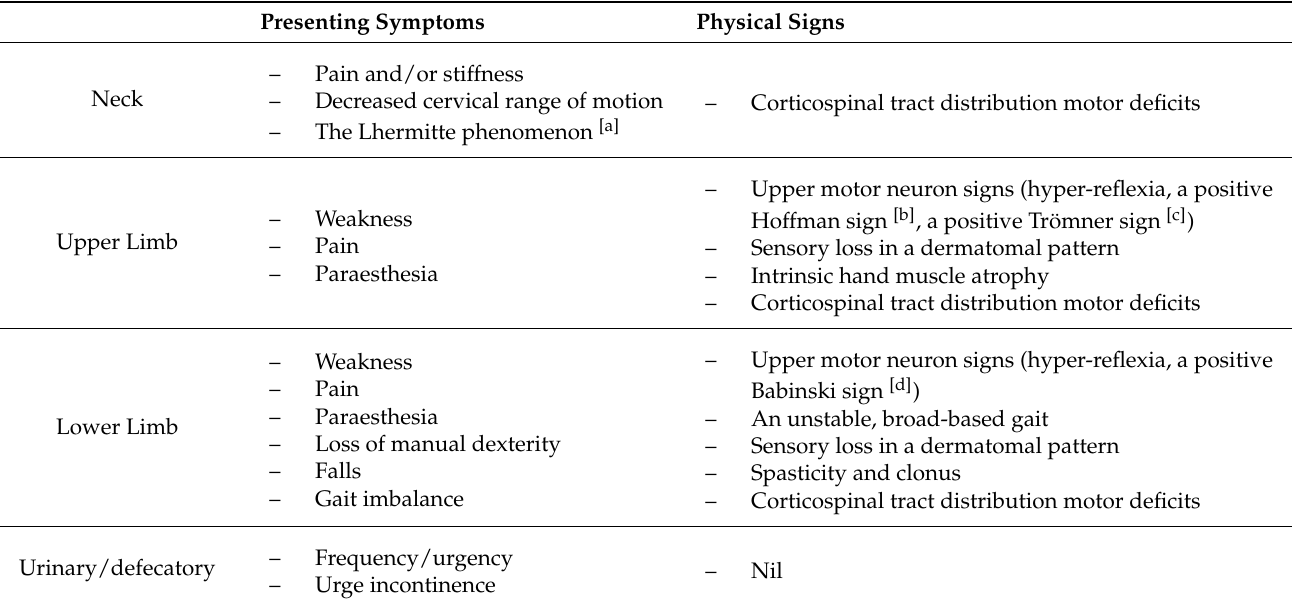
Table 1. Typical presenting symptoms and physical signs in DCM